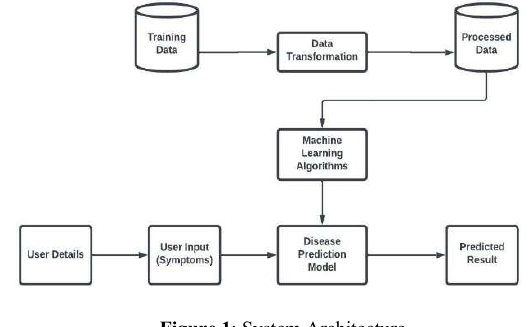
Figure 1 : System